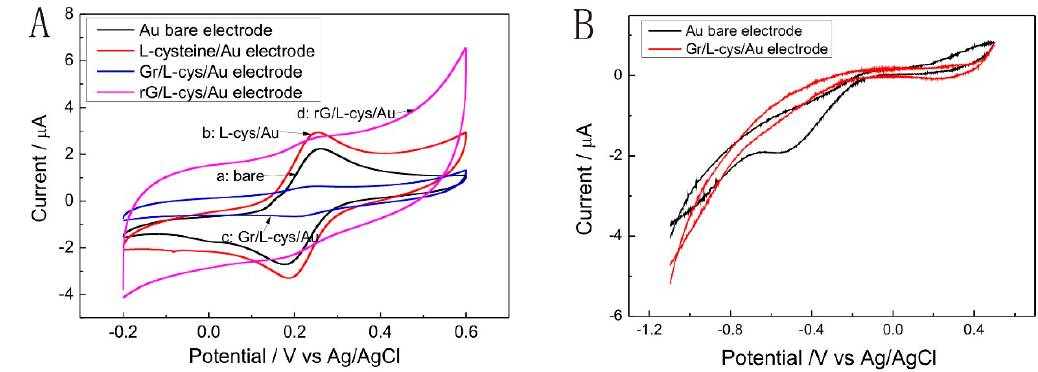
Figure 3. ( A ) Cyclic voltammograms of bare Au, L -cysteine/Au, Gr/ L -cys/Au, and rG/ L -cys/Au electrode in solution containing 0.5 mM ferri/ferrocyanide and 0.1 M KCl. ( B ) Cyclic voltammograms between −1.1 –0.5 V of H 2 SO 4 , pH 4.50, at an Au bare electrode and Gr/ L -cys/Au electrode.